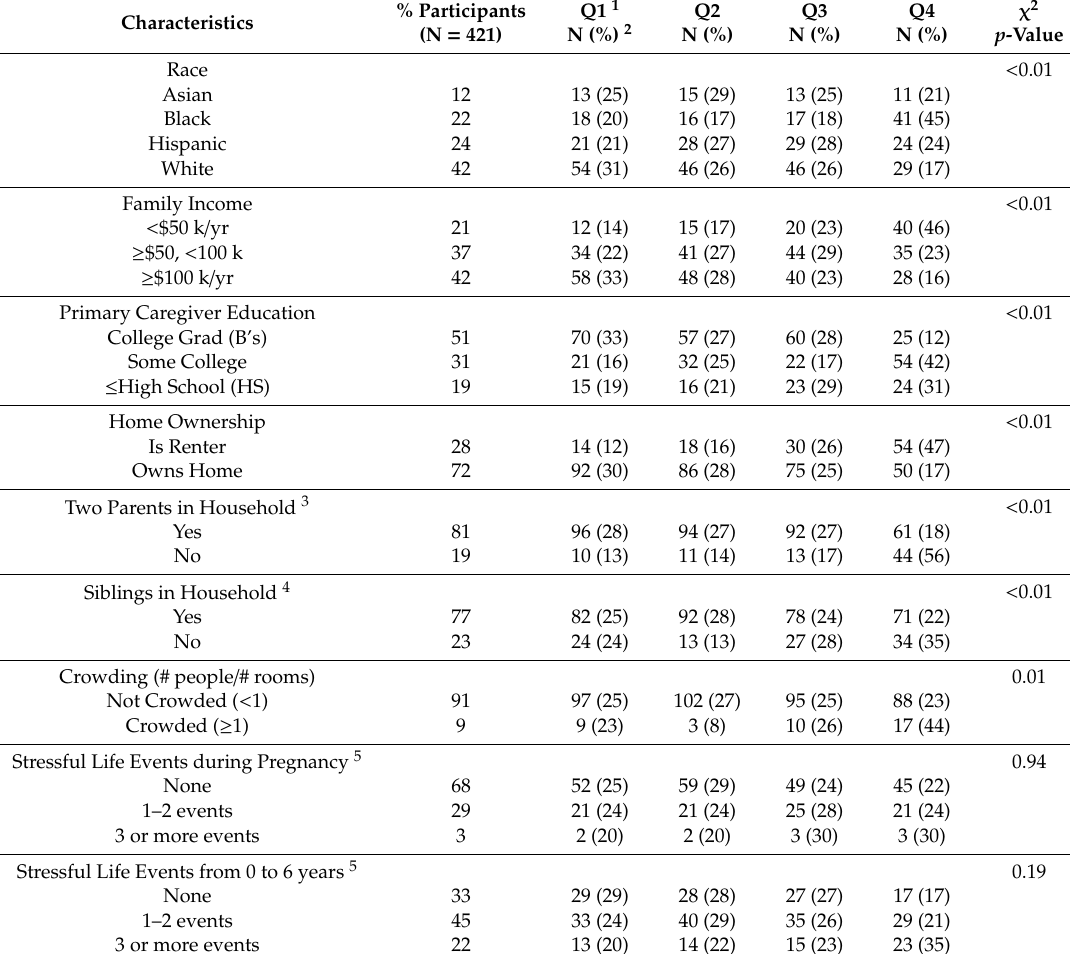
Table 1. Demographic and Household Structure Characteristics by Quartile of Urinary